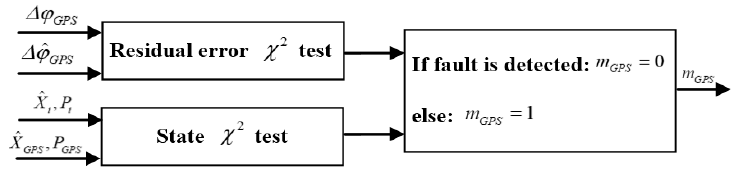
Figure 4. The diagram of the Fault_Signal_Detector_1.